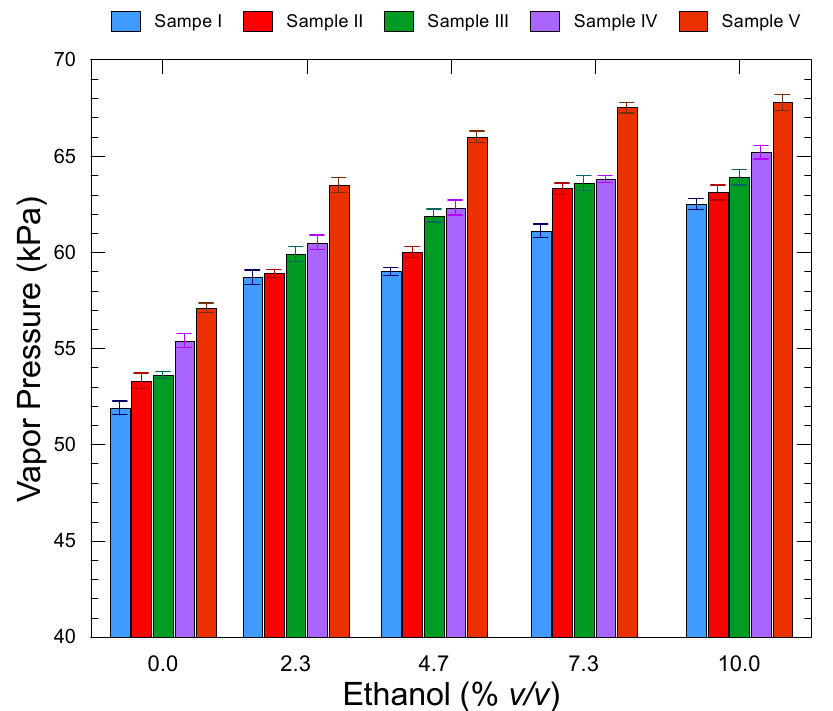
Figure 3. Vapor pressure of blends with bio-ethanol and bio-ETBE in relation to the bio-ethanol content (oxygen content 3.7% m / m in all cases). content (oxygen content 3.7% m / m in all